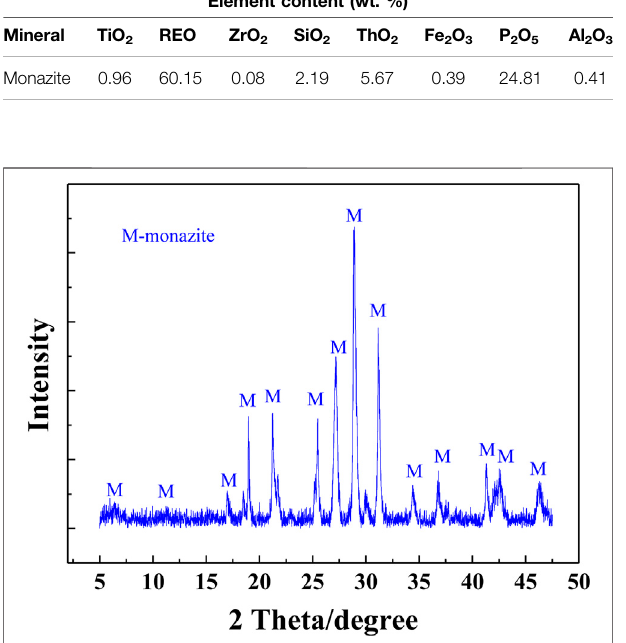
FIGURE 2 | XRD patterns of monazite samples with monazite phase labeled.